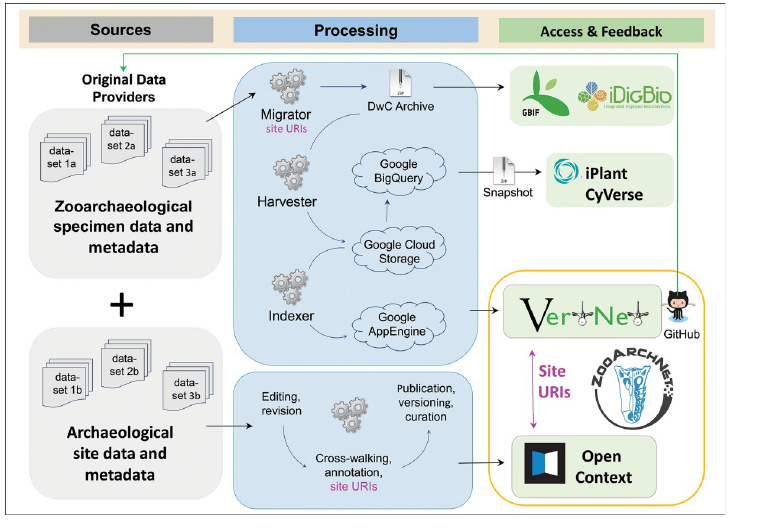
Fig 1. ZooArchNet